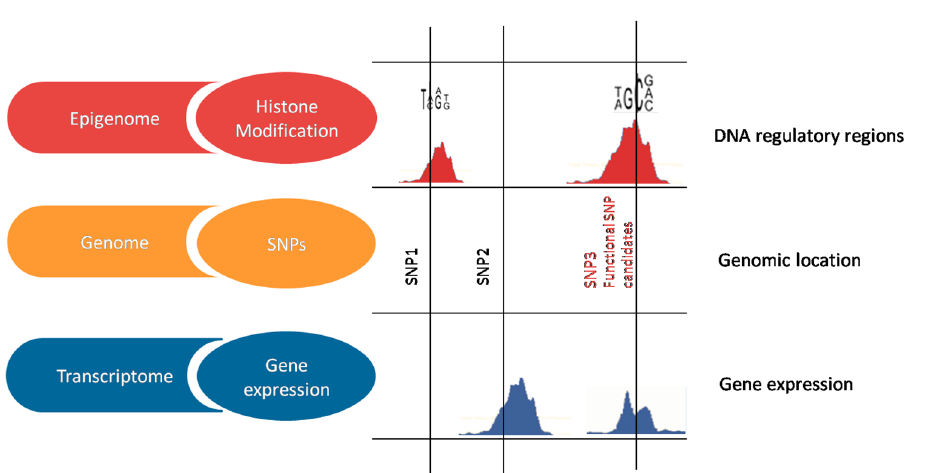
Figure 2. Principle of functional SNP candidates identified by iTEA using integrative strategy. SNP3 is a functional SNP candidate, as it affects the expression of a flanking gene at the transcriptional level, and it is located in a DNA regulatory region. SNP1 and SNP2 are discarded due to lack of one of the